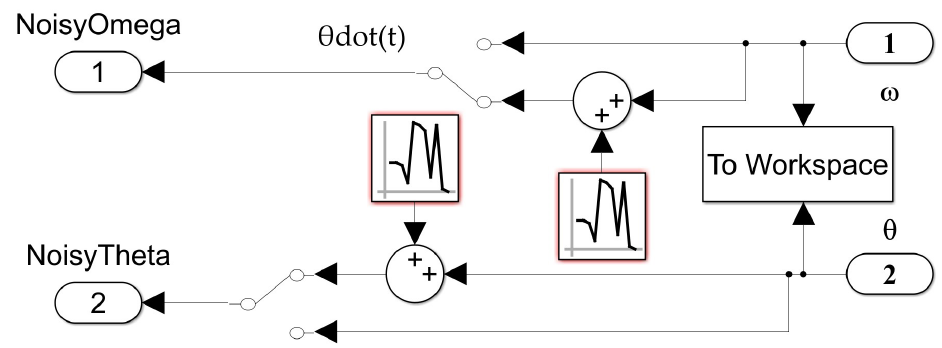
Figure A1. Upper level Simulink model.